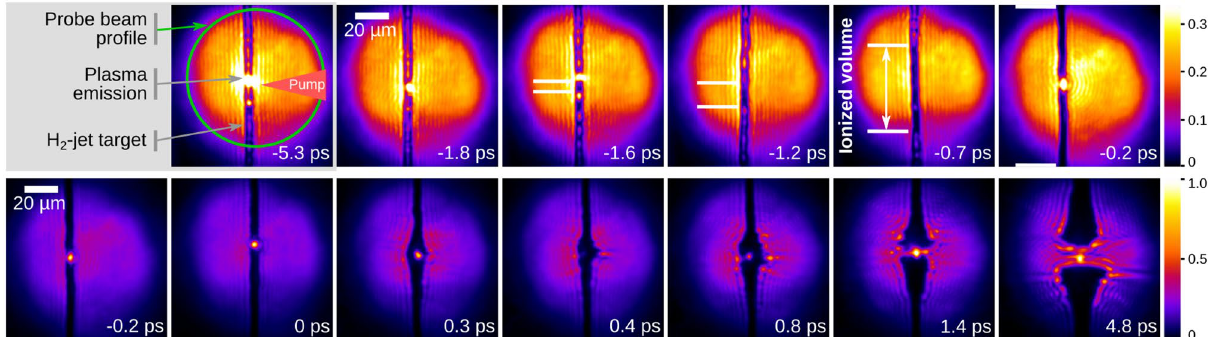
Figure 3. Shadowgraphy images for different pump-probe delays at 5.4 × 10 21 W/cm 2 pump laser intensity. images. For better visibility of the onset of target ionization (indicated between the horizontal white bars) and the subsequent plasma expansion dynamics, the color scale is different in both